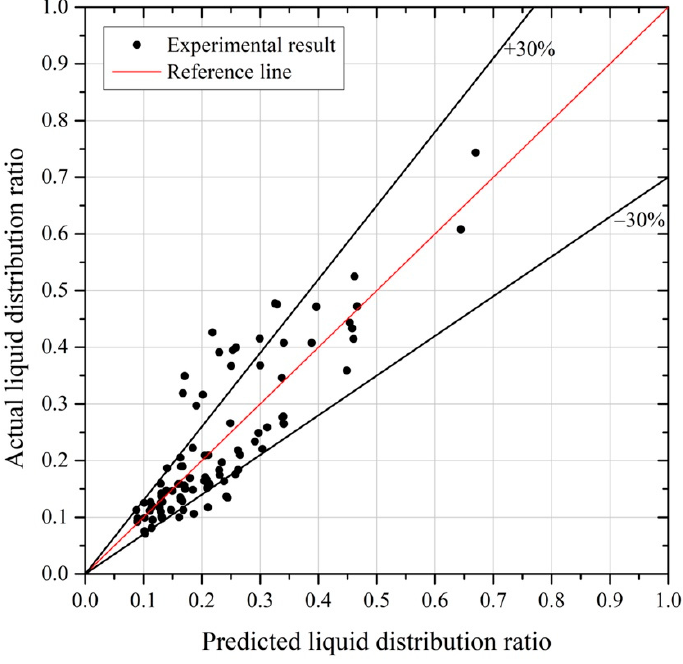
Figure 14. Predicted vs. actual liquid distribution ratio.